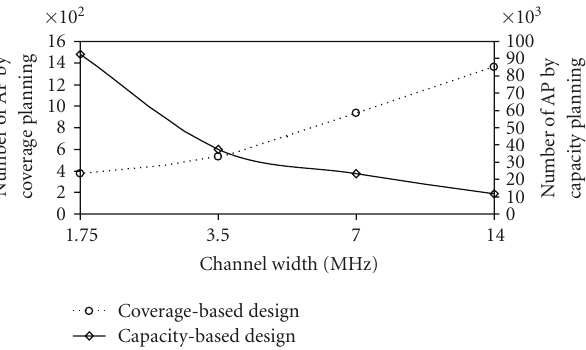
Figure 10: Coverage design versus capacity